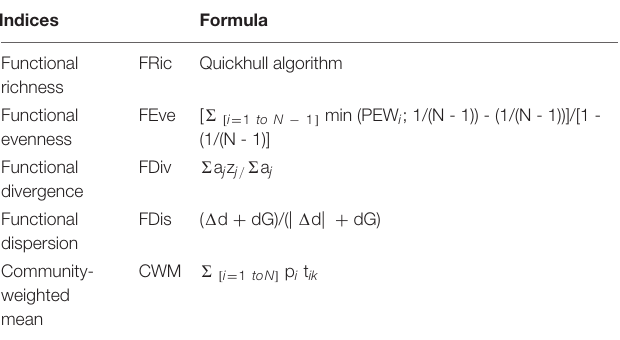
TABLE 4 | Functional diversity measures adapted from Mouchet et al. (2010) and CWM (Lavorel et al.,